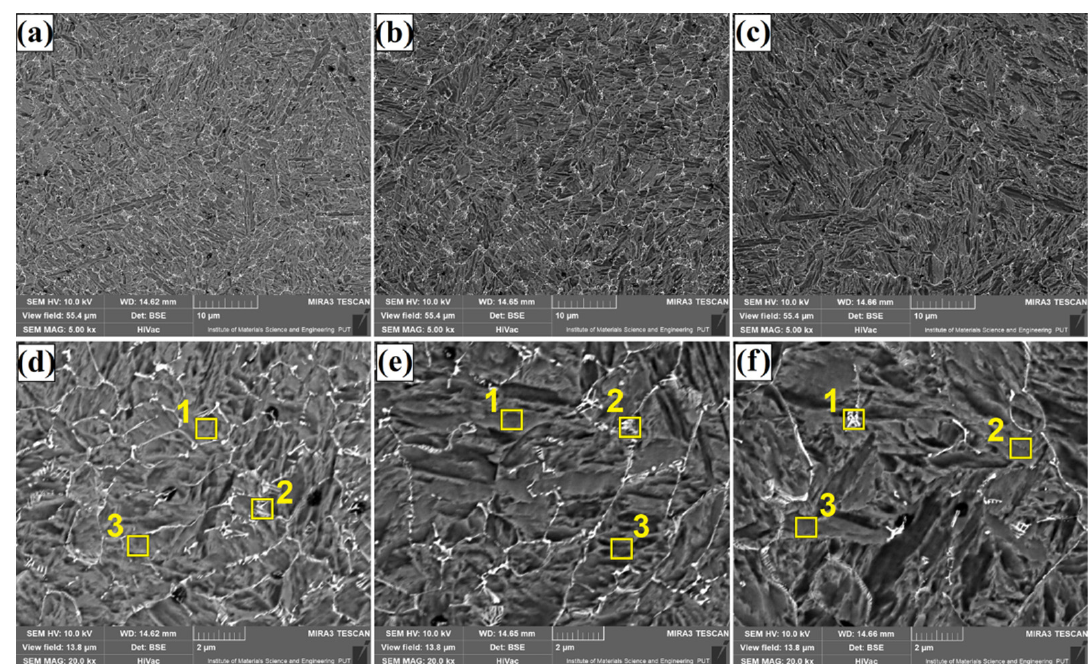
Figure 5. Middle area of the Fe/TaC coatings produced on tool steel using 30 µm thick pre-coat and laser beam power of 500 W ( a , d ), 800 W ( b , e ), 1100 W ( c , f ).